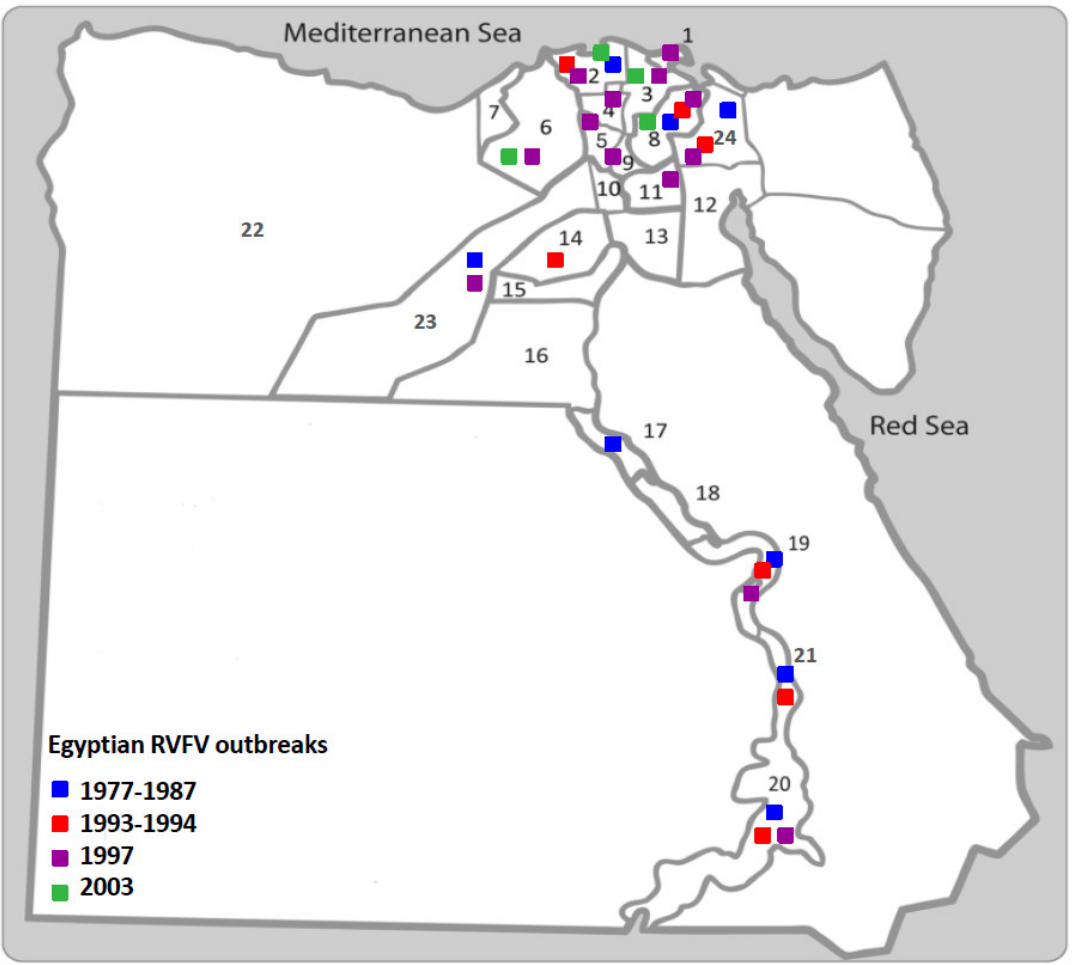
Figure 3. Distribution of RVF epidemics in Egypt. Egypt map shows different Egyptian provinces including: (1) Damietta, (2) Kafr El-Sheikh, (3) El-Dakahlia, (4) El-Gharbia, (5) El-Menofia, (6) El-Beheira, (7) Alexandria, (8) El-Sharquia, (9) El-Qalubia, (10) six of October, (11) Cairo (12) El-Suez, (13) Helwan, (14) El-Faiyoum, (15) Beni-Suef, (16) El-Menia, (17) Assiut, (18) Sohaj, (19) Qena, (20) Aswan, (21) Luxur, (22) Marsa Matrouh, (23) Giza, and (24) Ismailia. Blue dots represent the first outbreak (1977–1978), red dots represent the 1993–1994 outbreak, purple dots represent the 1997 outbreak, and the green dots represent the 2003 outbreak.